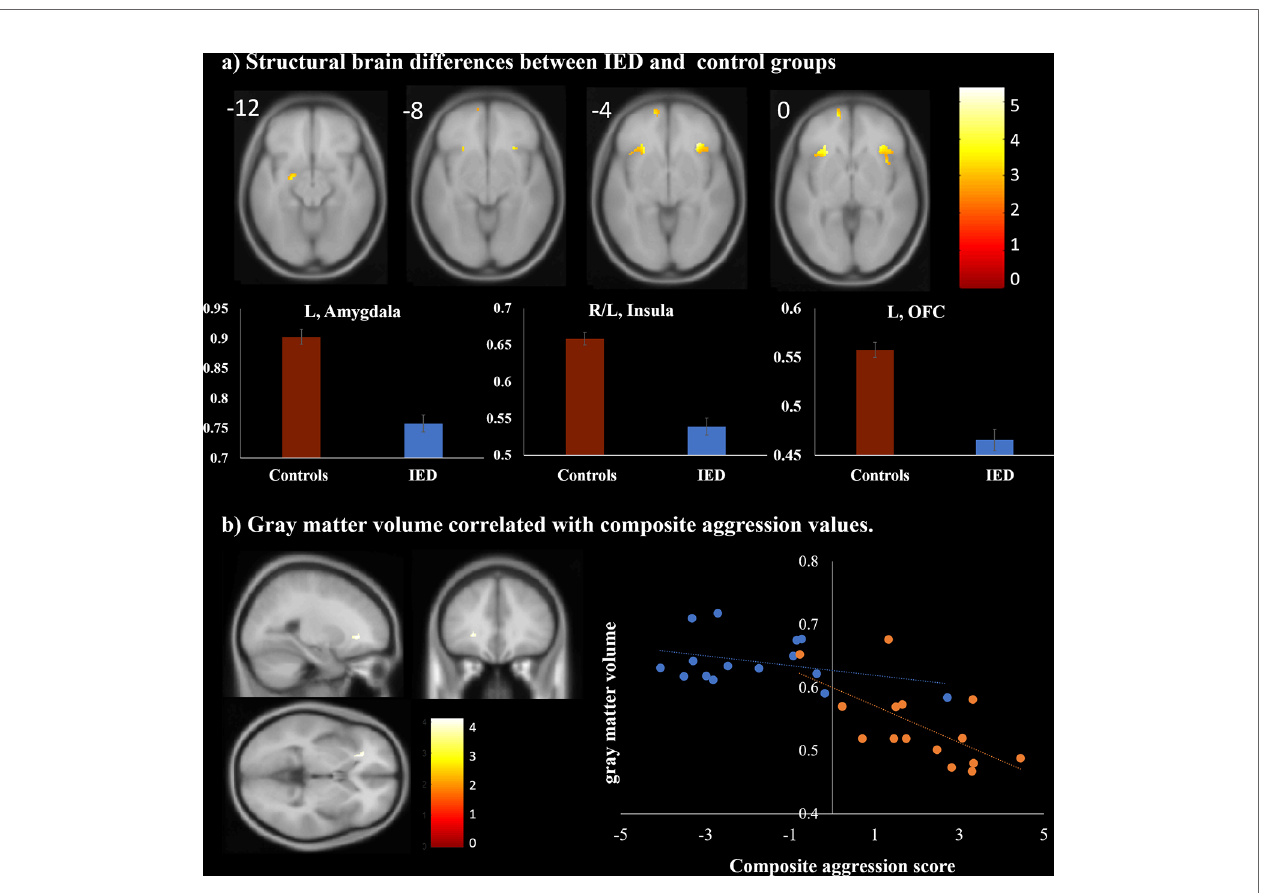
FIGURE 2 | Structural magnetic resonance imaging fi ndings of individuals with intermittent explosive disorder (IED) and healthy controls. (A) Regions showing gray matter reduction in individuals with IED relative to controls [p < 0.05, false discovery rate (FDR) corrected]. (B) Brain region map and scatter plots of the correlation between the composite aggression score and the gray matter volume in the left insula (p < 0.001, uncorrected). Each orange and blue circle represents the data of an IED and control participant, respectively.